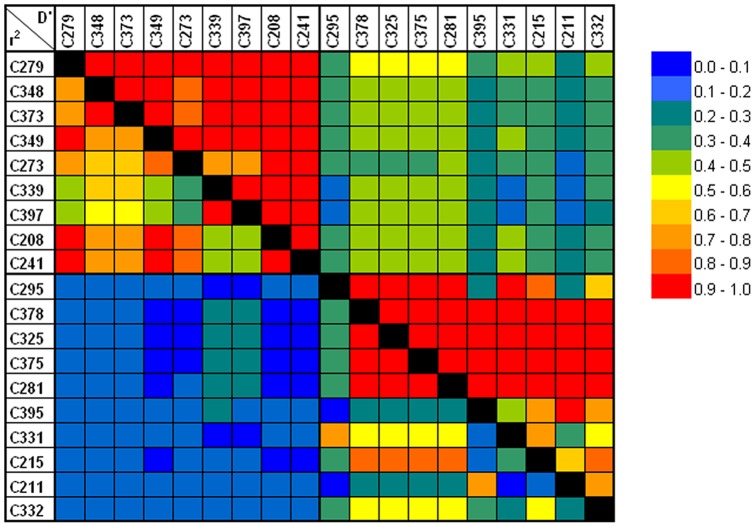
LD between the associated HLA-A SSOPs.Below the diagonal the r2 values are given and above the diagonal the D' values. The SNPs are sorted according the HLA-A allele specificity and strength of association with EBV status (same order as table 5). SSOPs C279–C241 in the left/upper part are specific for HLA-A*02 and SSOPs C295–C332 in the right/lower are specific for HLA-A*01.